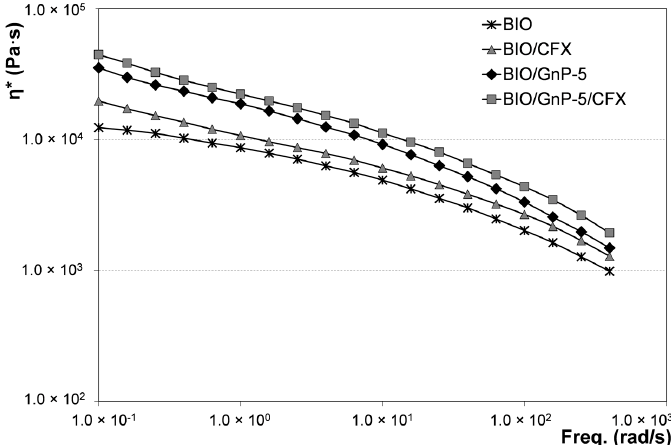
Figure 4. Complex viscosity as a function of frequency of systems incorporating CFX and of the respective systems without antimicrobial additive.